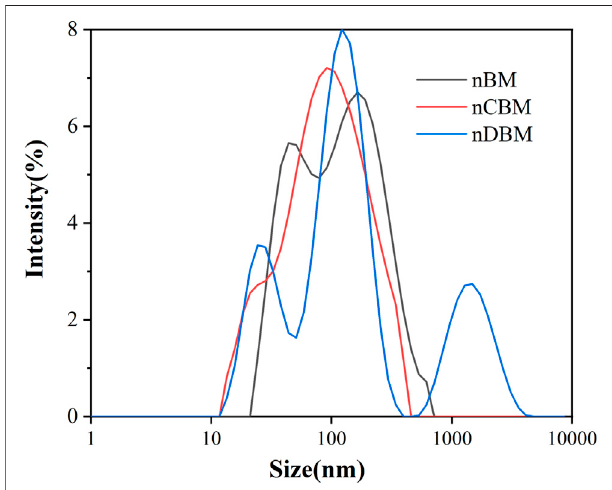
FIGURE 1 | Particle size distribution of different nano bone